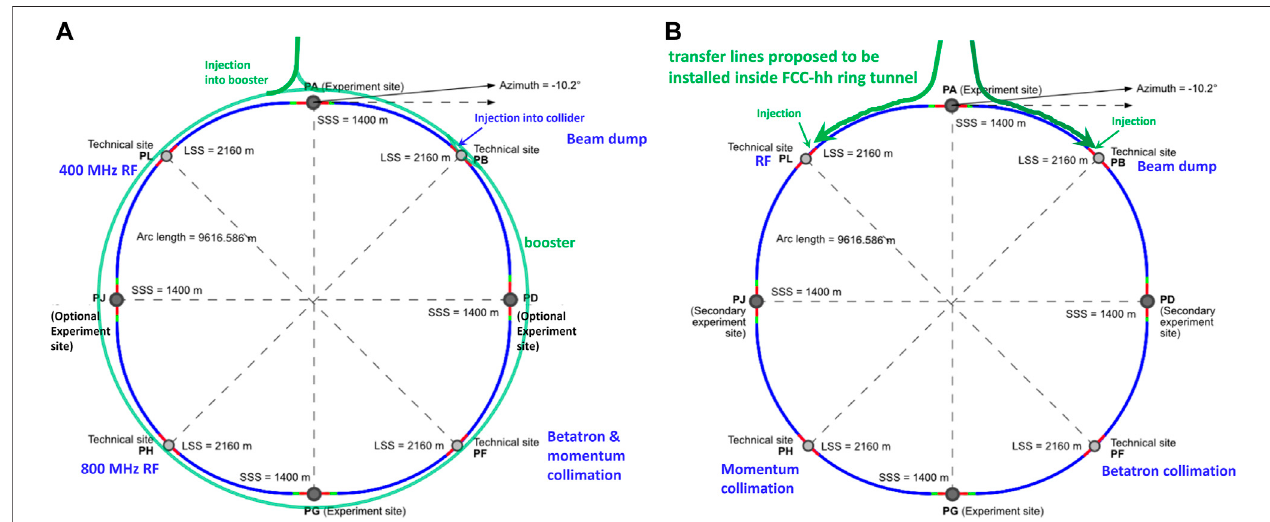
FIGURE 2 | Schematic layout of FCC-ee and its booster (A) and of FCC-hh (B) with a circumference of 91.2 km and strict four-fold superperiodicity.